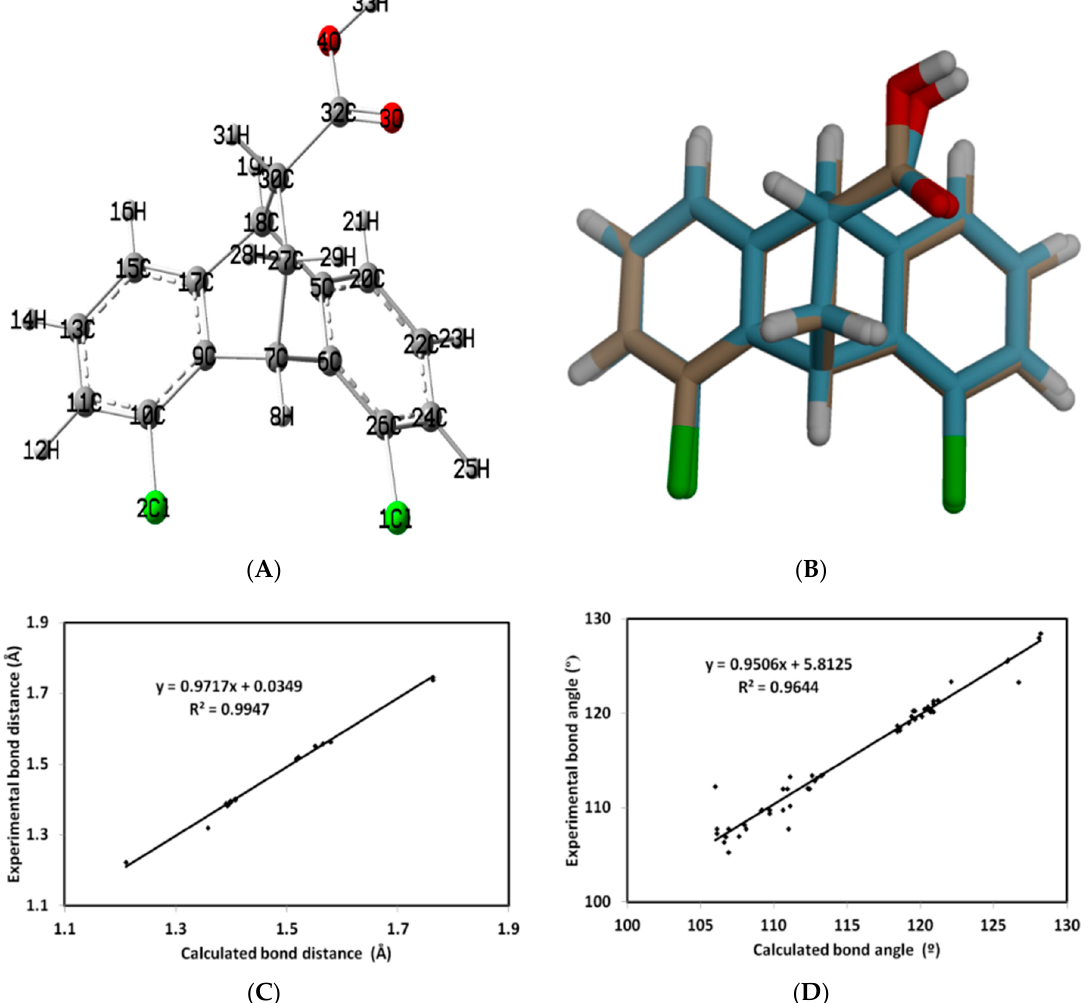
Figure 7. The optimized structure ( A ), overlaid with the experimental single-crystal X-ray analysis results, ( B ) as well as correlation graphs between the calculated and experimental bond distances ( C ) and angles ( D ) for